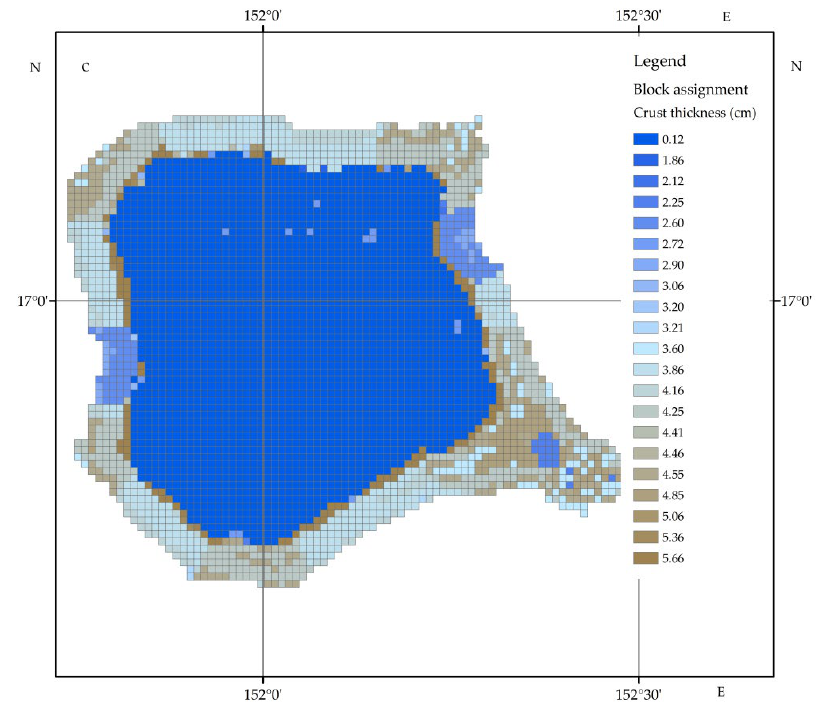
Figure 15. Mineralized block method assignment: ( a ) Micro-topography classification of blocks and their assignment; ( b ) geomorphic classification of blocks and their assignment; ( c ) block method assigns values to geostatistical units.